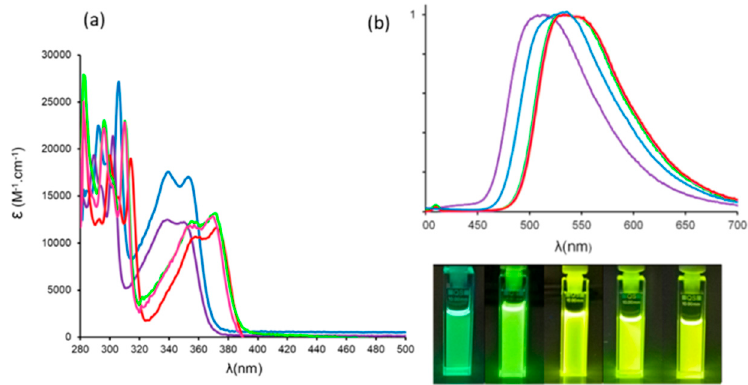
Figure 3. ( a ) UV-Visible spectra of HBO dyes 1 (purple), 2 (blue), 3 (red), 4 (green) and 5 (pink) recorded in toluene in aerated solution at 25 ◦ C, ( b ) emission spectra of HBO dyes 1 (purple), 2 (blue), 3 (red), 4 (green) and 5 (pink) recorded in toluene in aerated solution at 25 ◦ C, ( c ) photographs of toluene solutions of HBO 1 – 5 (from left to right) under irradiation at λ exc = 365 nm. Table 1. Photophysical data of HBO dyes 1 – 5 measured in aerated solution at 25 ◦ C.